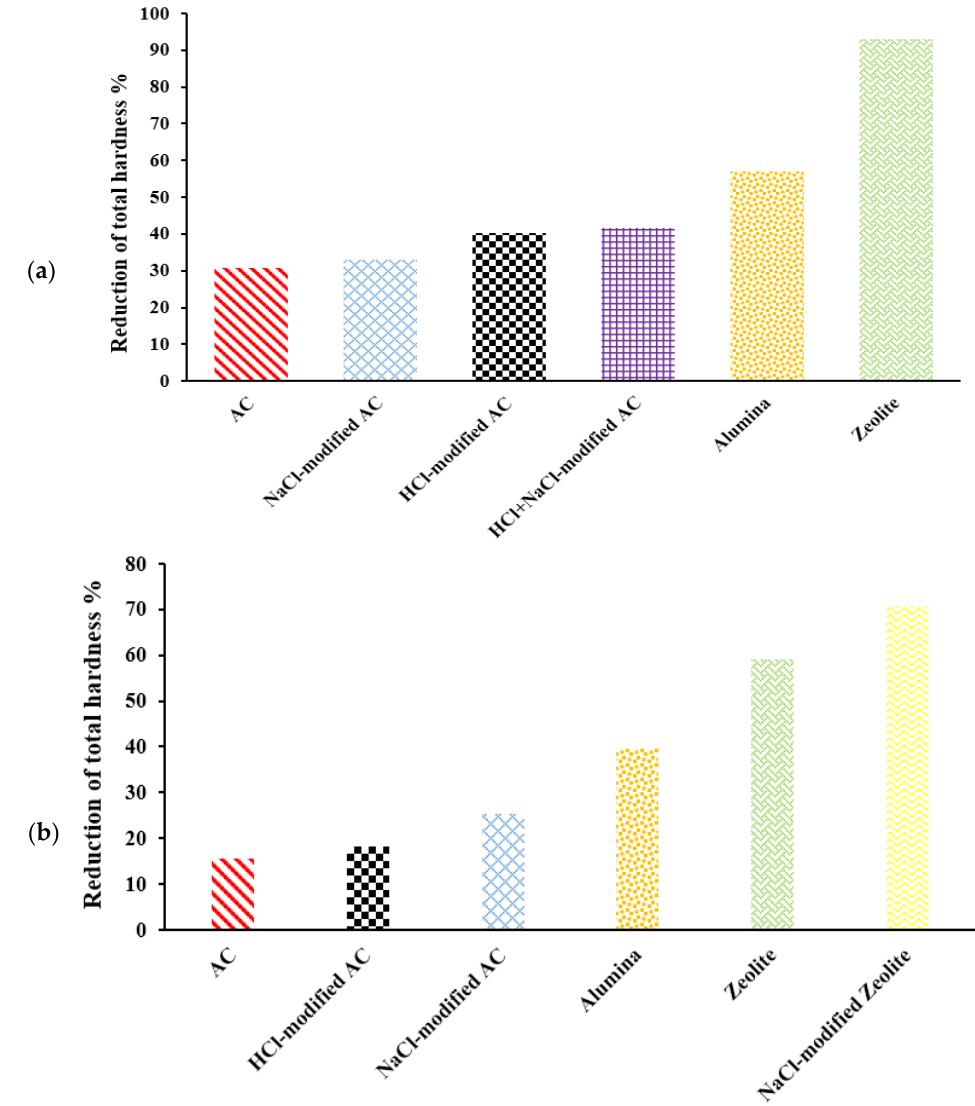
Figure 14. Comparison of reduction in the total hardness of ( a ) drinking water and ( b ) groundwater with natural and modified adsorbents under optimal conditions.